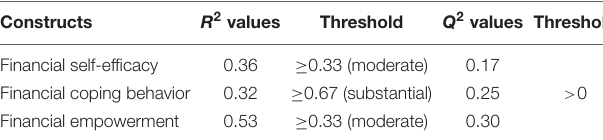
TABLE 3 | Determination coefficients ( R 2 ) and predictive relevance ( Q 2 ) of endogenous (omission distance =